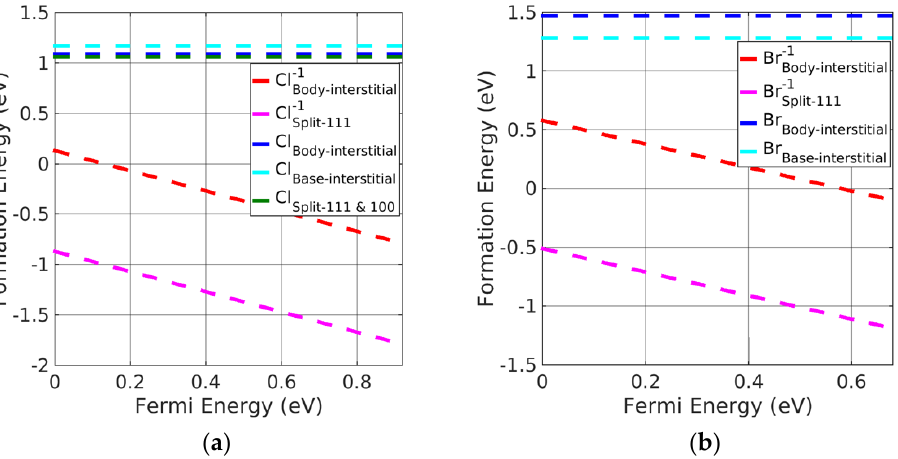
Figure 7. Formation energy of charged interstitial defects in ( a ) AgCl at Cl − rich and ( b ) AgBr at Br − rich conditions.